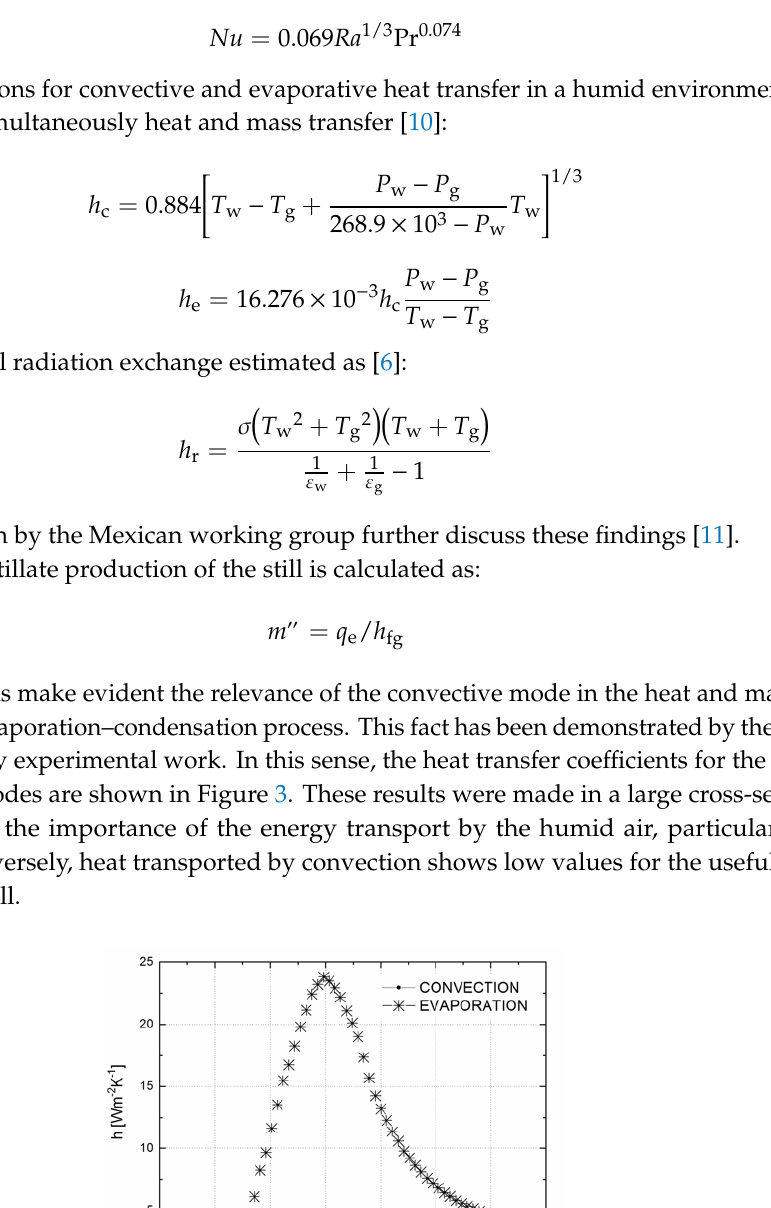
Figure 4. Distillate yield production for different mathematical models (Reprinted from [13], with permission from Elsevier, 2019). There is a linear dependence of the production of the still on water temperature and water ‐ to ‐ cover temperature differences as shown in Figure 5. This plot was obtained from experimental data for a laboratory still operated under controlled conditions.